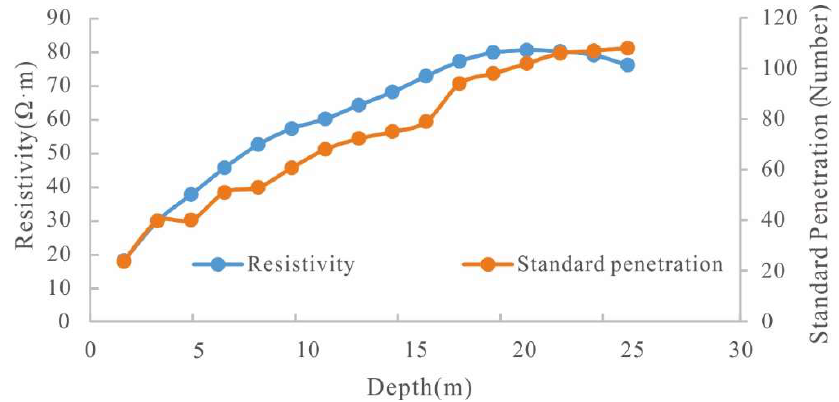
Figure 8. Electrical resistivity versus standard